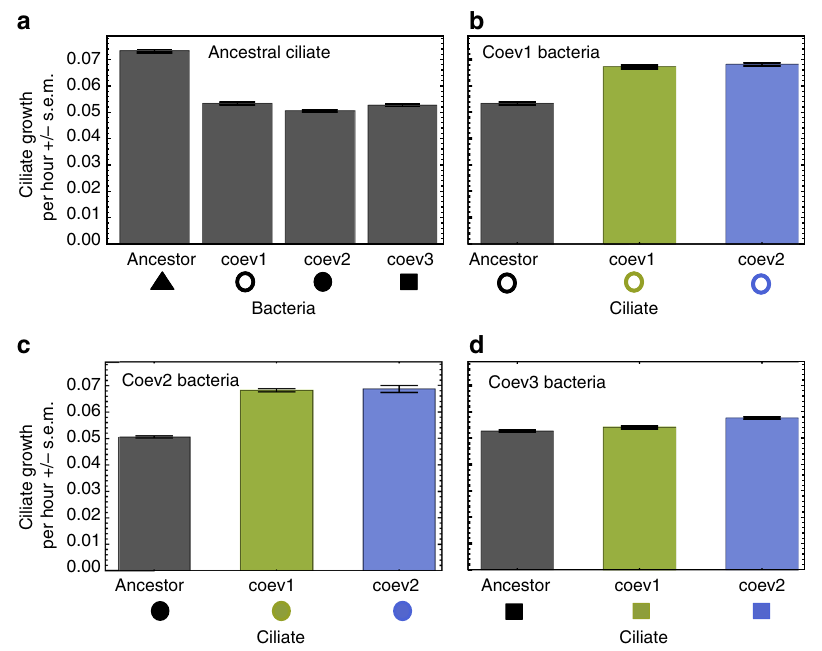
Fig. 1 Increase in bacteria defense and ciliate predation ability in coevolving predator-prey system. a Mean growth rate of the ancestral ciliate population ( Tetrahymena thermophila ) is higher when growing on ancestral than coevolved bacteria populations ( Pseudomonas fl uorescence ; isolated after ~1000 bacteria generations of co-culturing with the ciliate, Kruskal – Wallis test, χ 2 = 19.8, df = 1, p = 1.275 × 10 − 7 ). When growing on three coevolved bacteria populations, mean ciliate growth rates of the ancestral ciliate populations are lower than the growth rates of two coevolved ciliate populations (isolated after ~550 ciliate generations of co-culturing with the bacteria), b coevolved bacteria population one marked by empty circles (Kruskal – Wallis test, χ 2 = 5.4, df = 1, p = 0.007), c coevolved bacteria population two marked by fi lled circles (Kruskal – Wallis test, χ 2 = 5.4, df = 1, p = 0.007), d coevolved bacteria population three marked by fi lled squares (Kruskal – Wallis test, χ 2 = 4.3, df = 1, p = 0.025). Shown are mean and standard errors of 3 technical replicates. Symbols below the x -axes correspond to the data points in Fig. 2